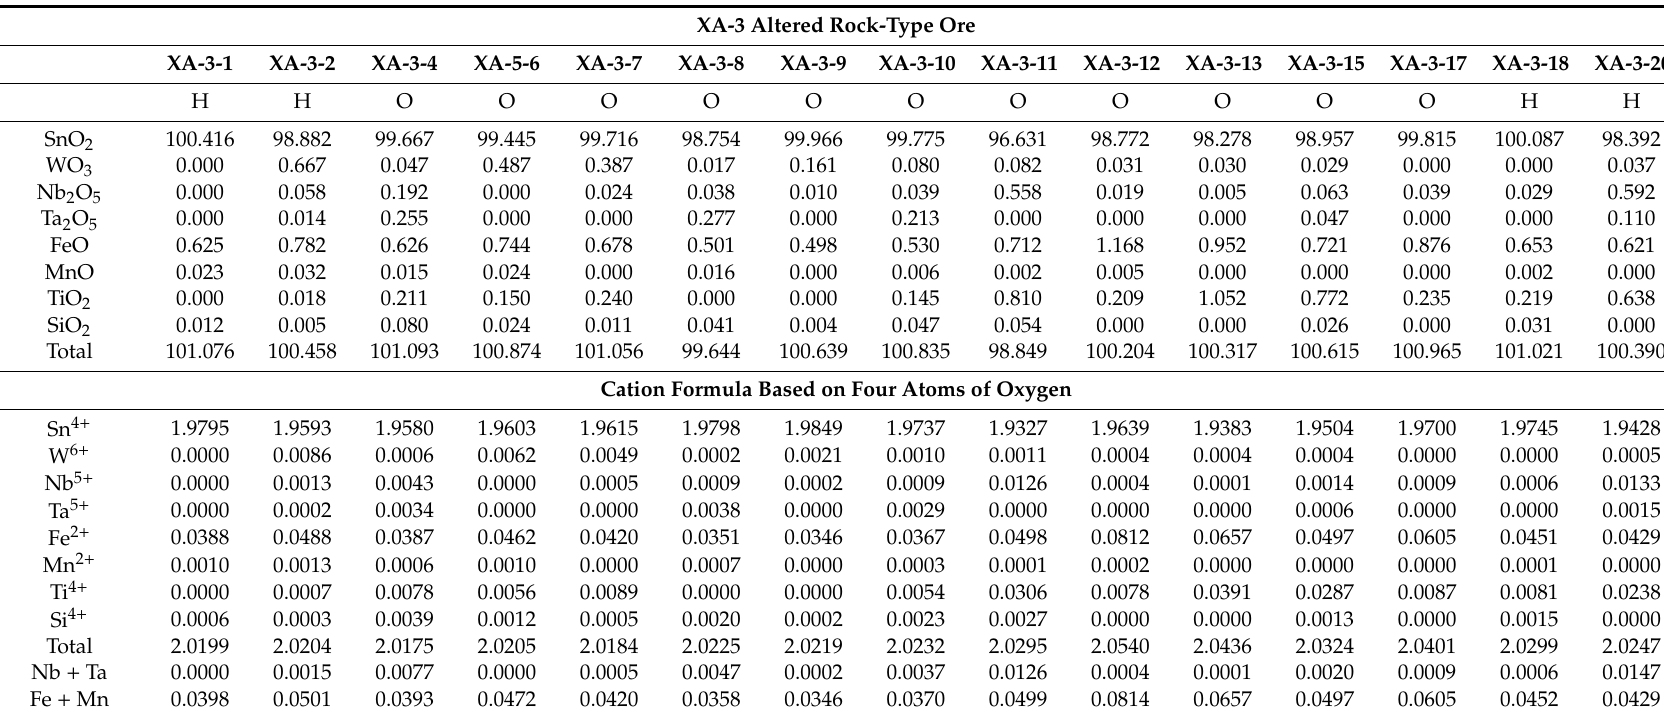
Table 3. Electron probe micro-analyzer (EPMA) data on cassiterites from Xi’ao Cu-Sn polymetallic